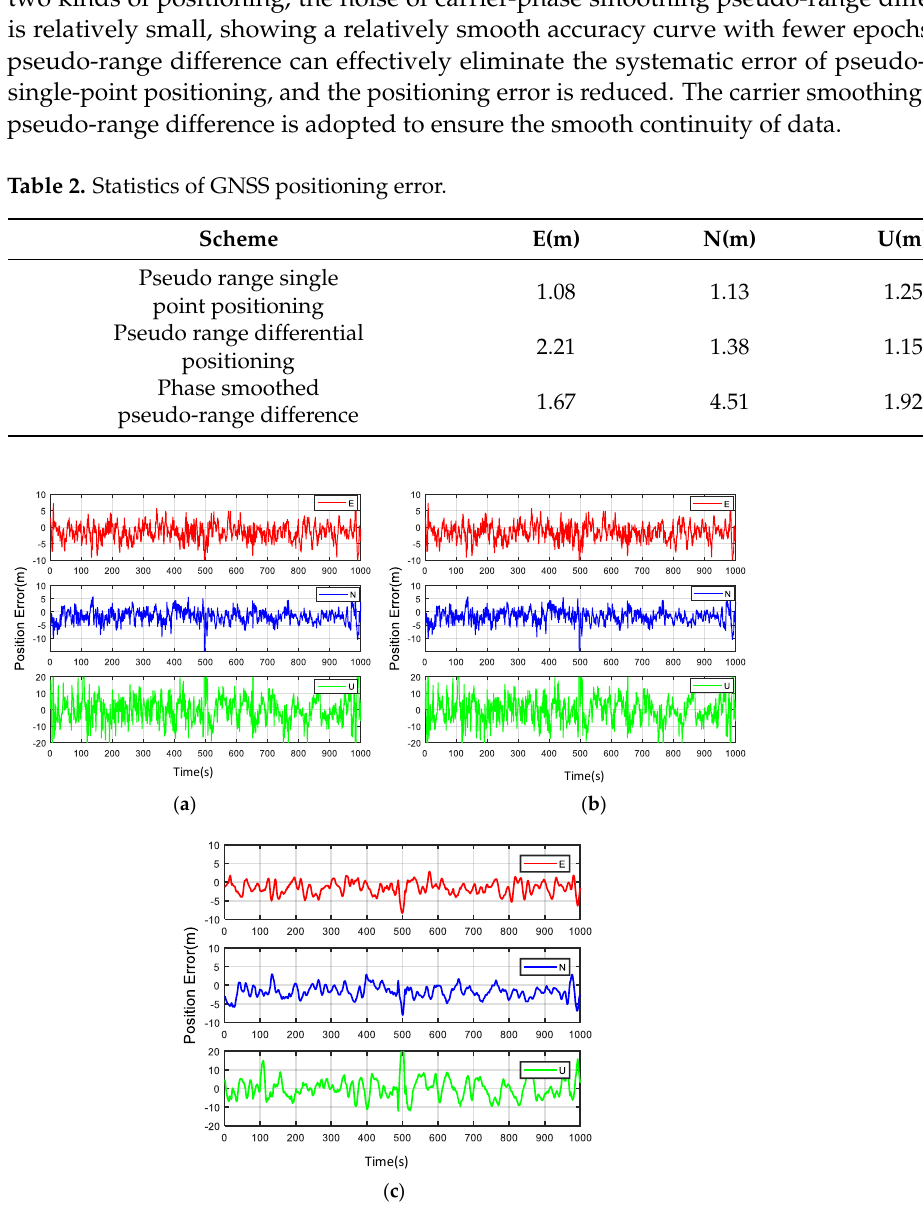
Figure 9. The GNSS positioning error. ( a ) Pseudo-range single-point positioning; ( b ) pseudo-range differential positioning; ( c ) carrier-smoothed pseudo-range differential location.